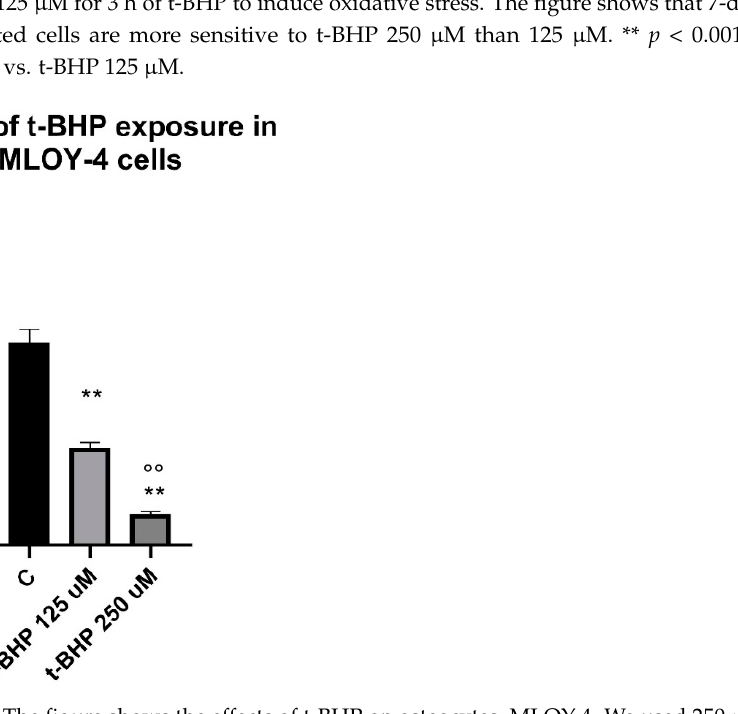
Figure A2. The figure shows the effects of t-BHP on osteocytes, MLOY-4. We used 250 µ M or 125 µ M for 3 h of t-BHP to induce oxidative stress. The figure shows that MLOY-4 cells are more sensitive to t-BHP 250 µ M than 125 µ M. ** p < 0.001 vs. control. ◦◦ p < 0.05; vs. t-BHP 125 µ